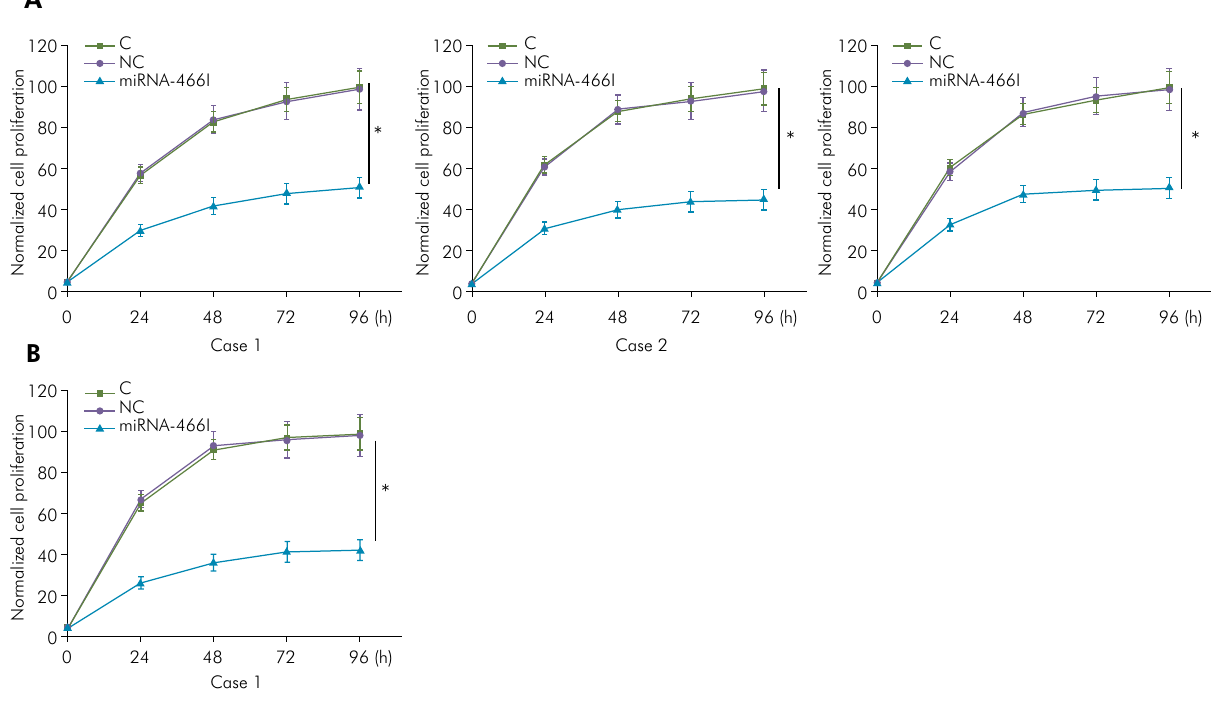
Figure S1. Effects of microRNA-466l overexpression on the proliferation of three cultures of PDLSCs derived from periodontitis- affected teeth (a) and one culture of PDLSCs derived from healthy teeth